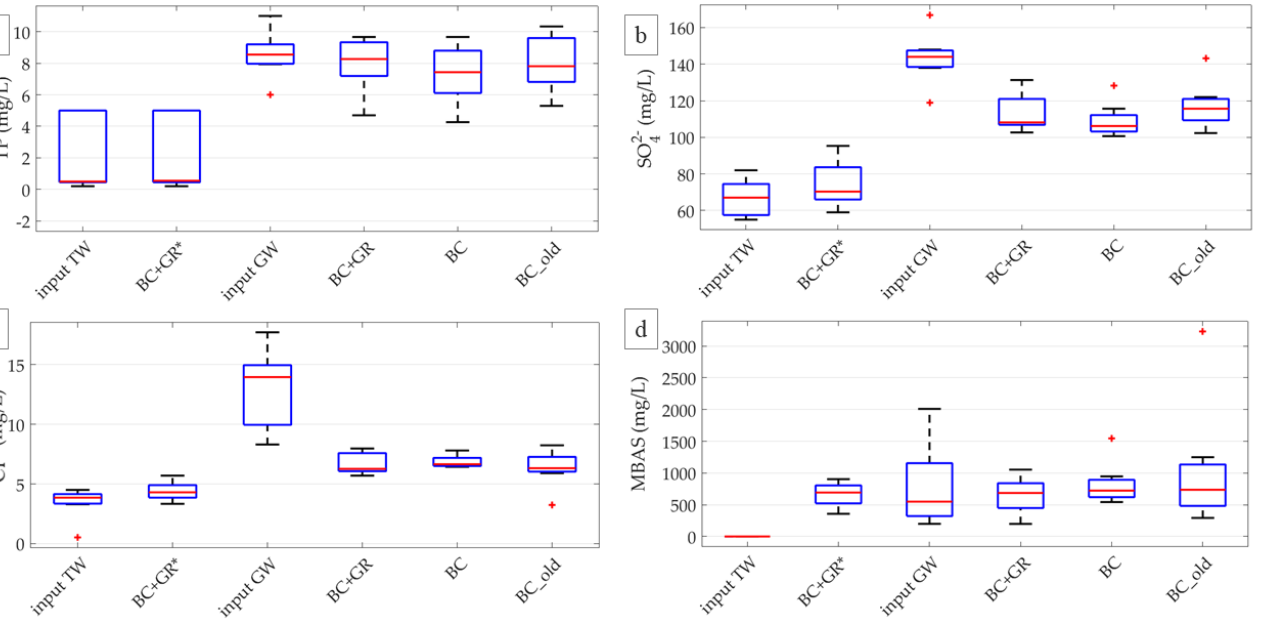
Figure 4. Values of the parameters measured off-site on input (TW and GW) and output water from all configurations (( a ): TP, ( b ): SO 42 − , ( c ): Cl − , ( d ): MBAS). Median value (red line), 25th and 75th percentiles (blue box), range (black whiskers) and outliers (red cross) are shown.